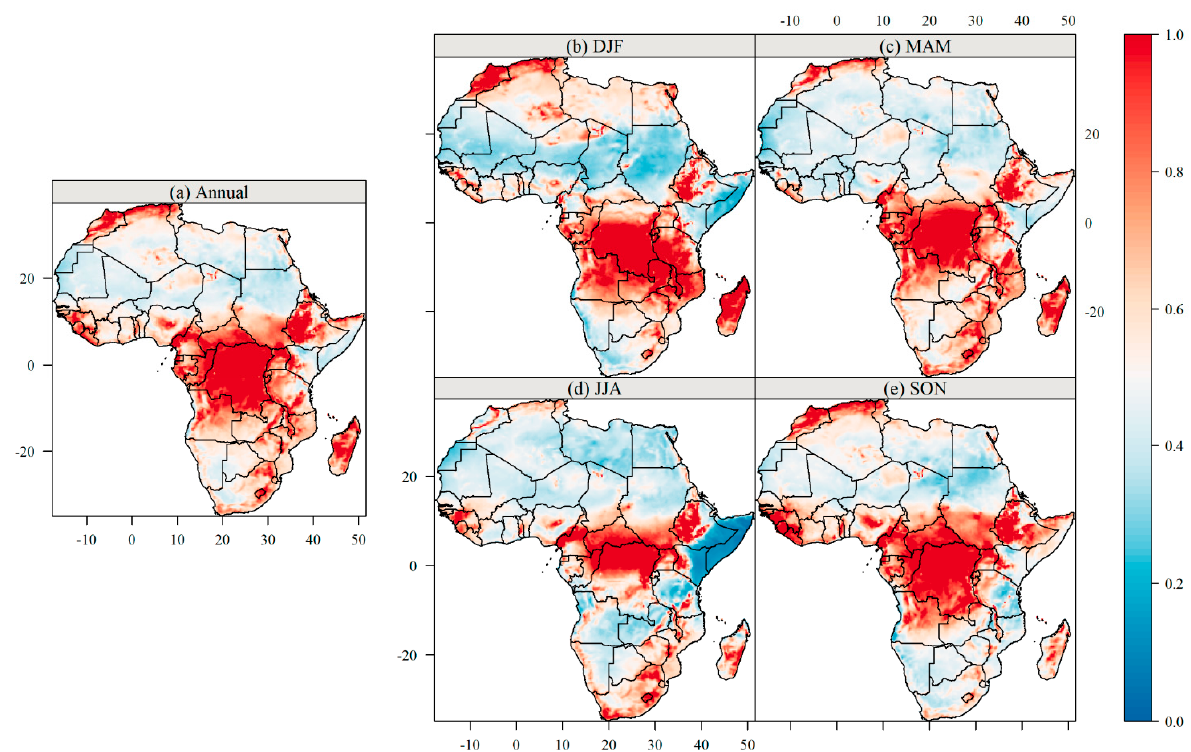
Figure 4. The annual and seasonal variability of daily CF in terms of coefficient of variation over the study period (2000– 2017): ( a ) over the year; ( b ) DJF (December, January, February); ( c ) MAM (March, April, May); ( d ) JJA (June, July, August) and ( e ) SON (September, October, November). The coefficient of variation is calculated by dividing the standard deviation by mean ( σ / μ , where μ and σ are the mean and the standard deviation of daily CF for a desired season over the study period). For the sake of readability, CV values greater than 1 were set to 1.